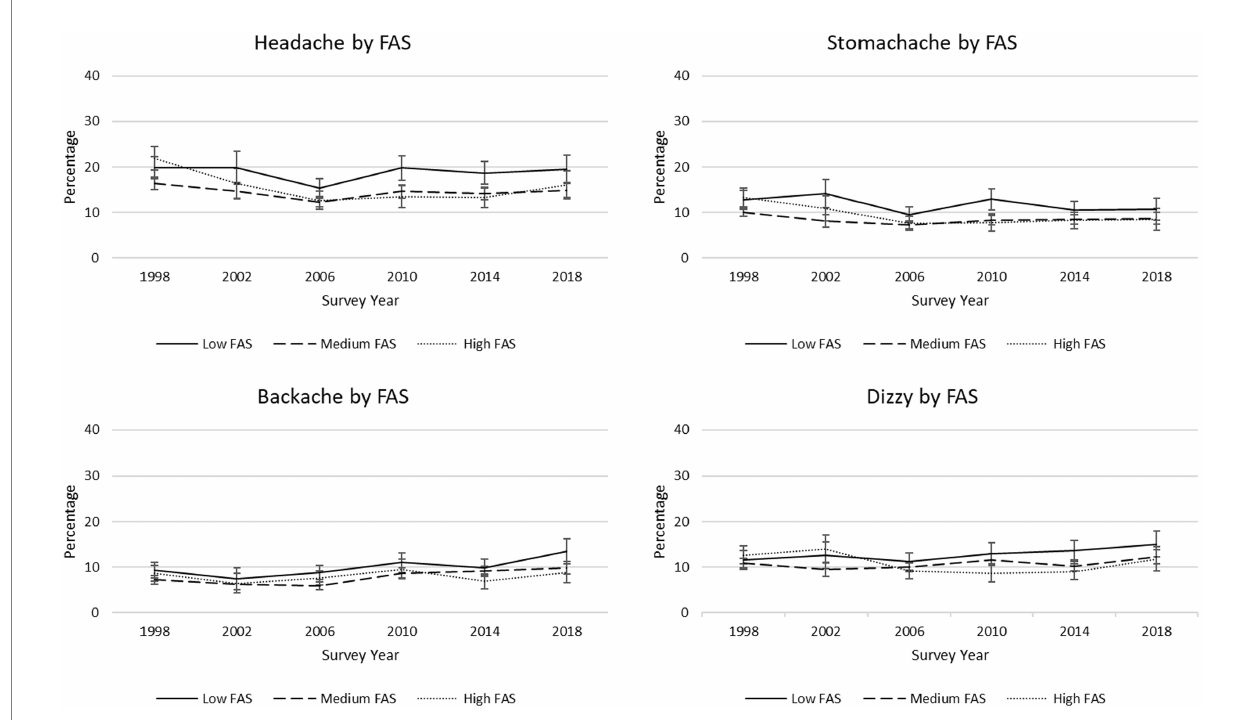
FIGURE 5 Trends in percentages of reported somatic symptoms, by Family Affluence Scale (FAS). 95% confidence intervals are